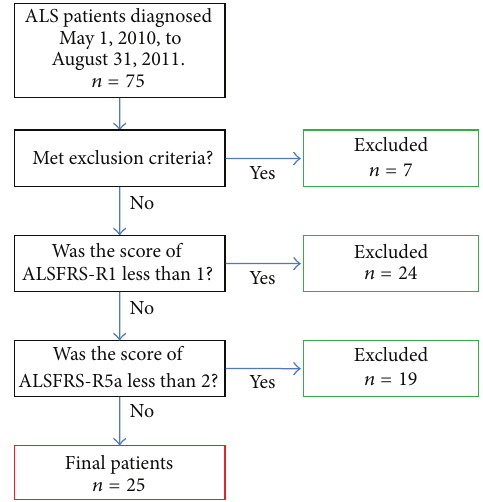
Figure 1: Flowchart showing the sequence of participant